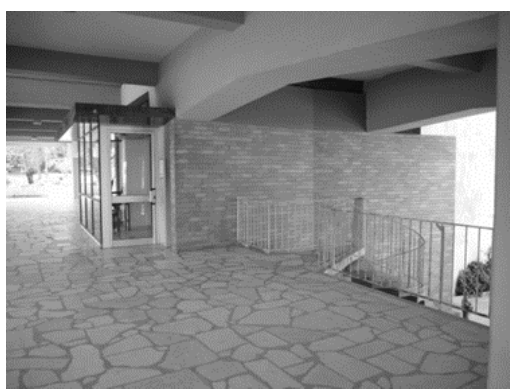
Figure 12. Entrance. The relation with the spiral stairs.